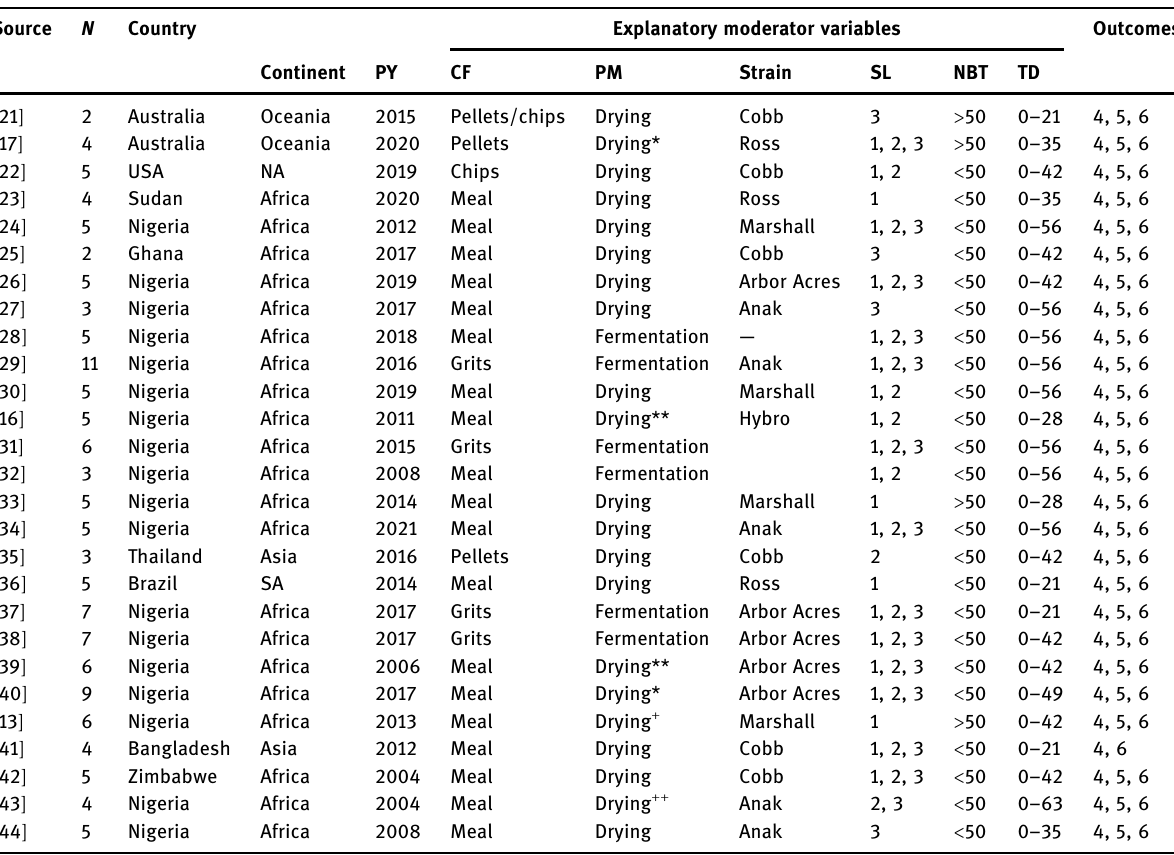
Table 1: Summary of studies included in the meta -